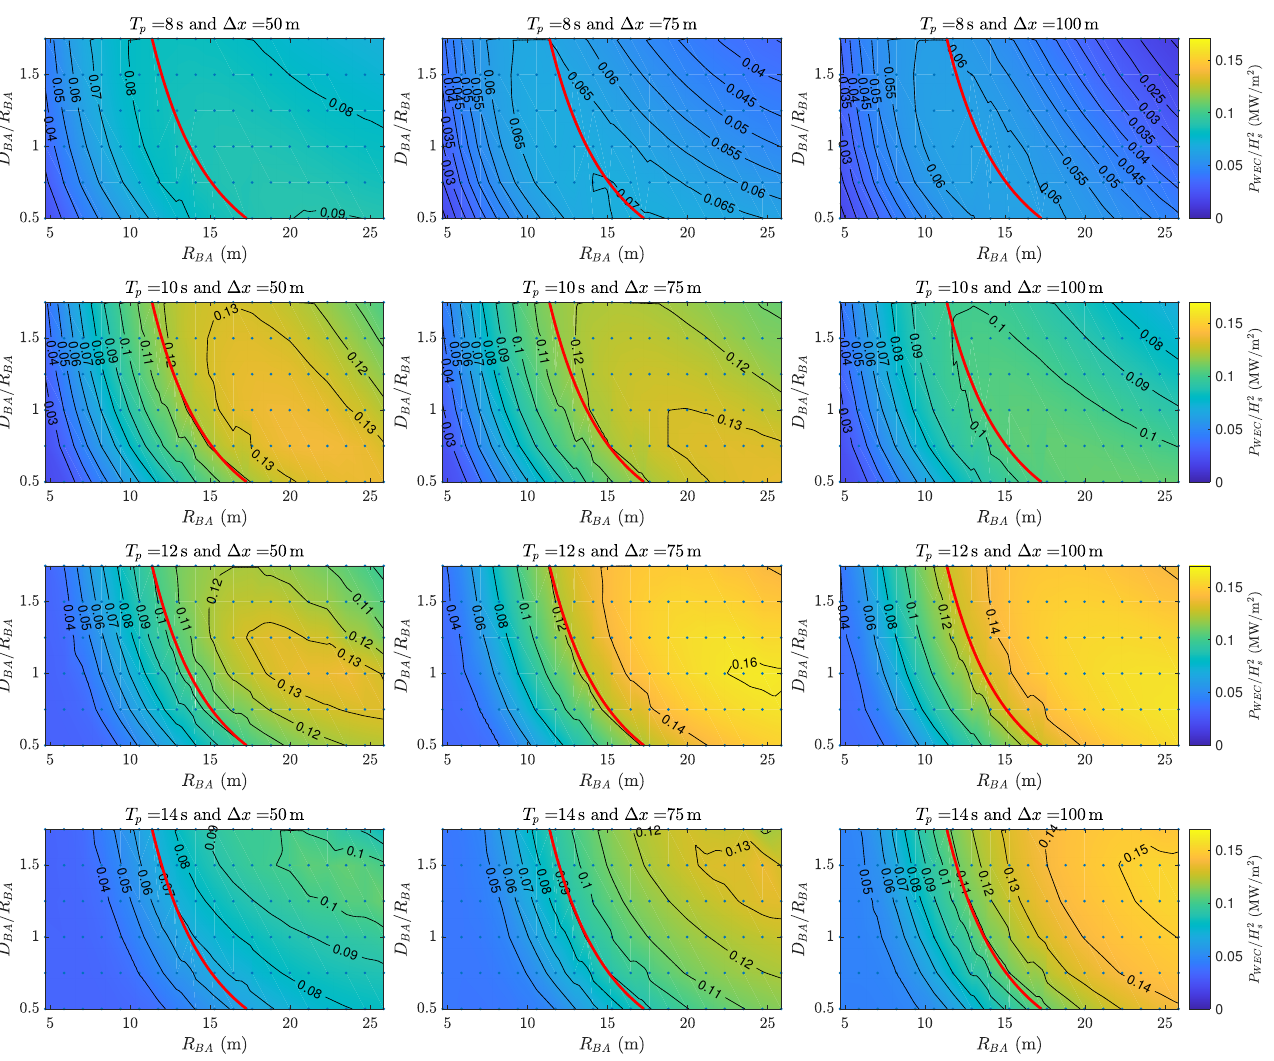
Figure 3. Power (scaled to wave height) generation as a function R BA and D BA . Left to right: varied separation distances. Top to bottom: varied peak wave period. Red curve is the locus of m spar = m BA